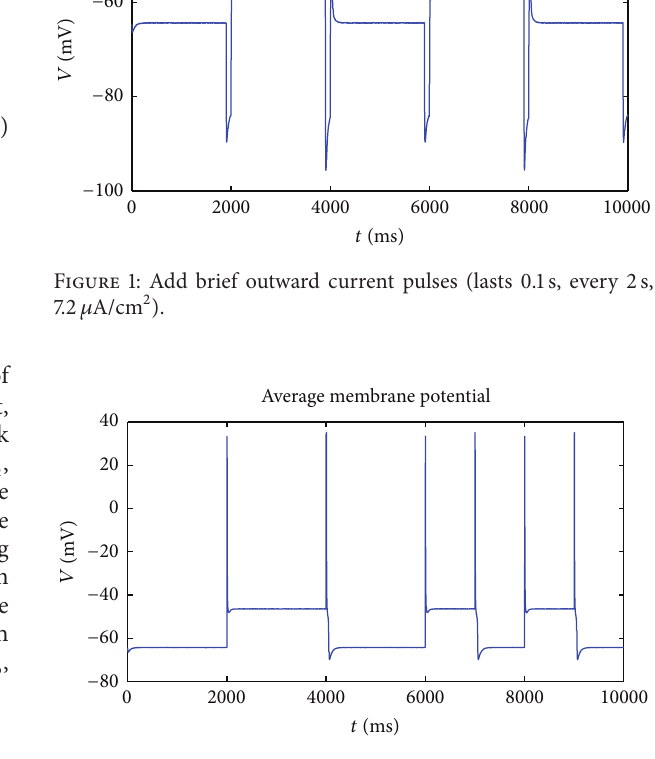
Figure 2: Increase the sodium conductance instantaneously (0.06 mS/cm 2 to 1.2mS/cm 2